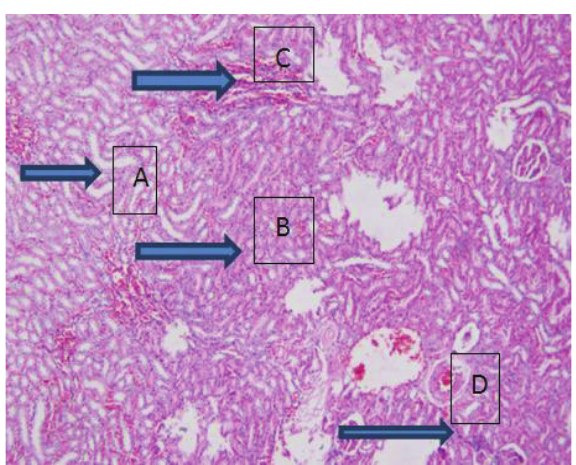
Fig-3: Showing protective effect on kidney tissue in group 3 received extract of Beta vulgaris